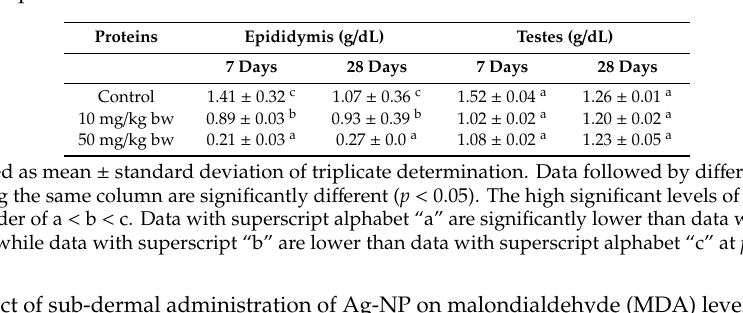
Table 8. E ff ects of sub-dermal administration of Ag-NP on protein concentrations in testes and epididymis experimental rats.